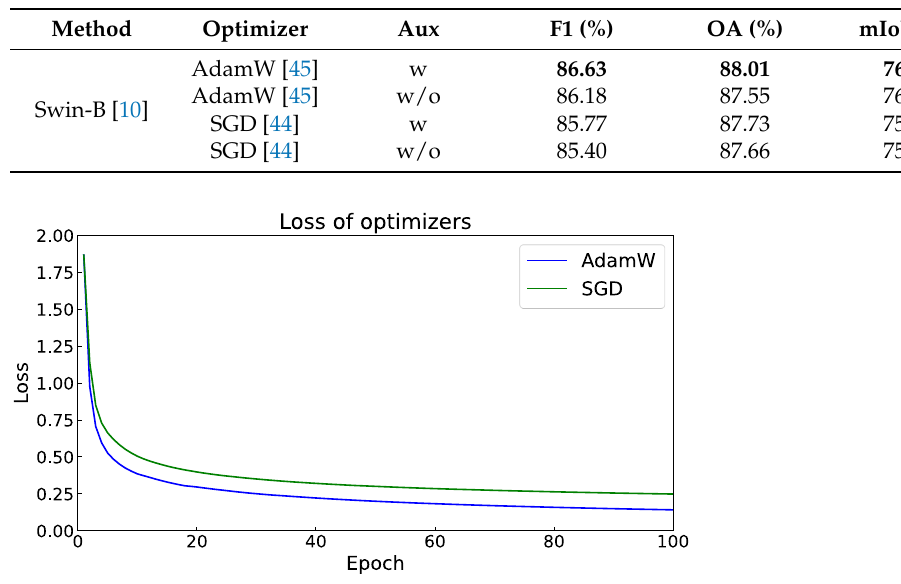
Figure 11. Epoch vs. Loss of Adamw and SGD